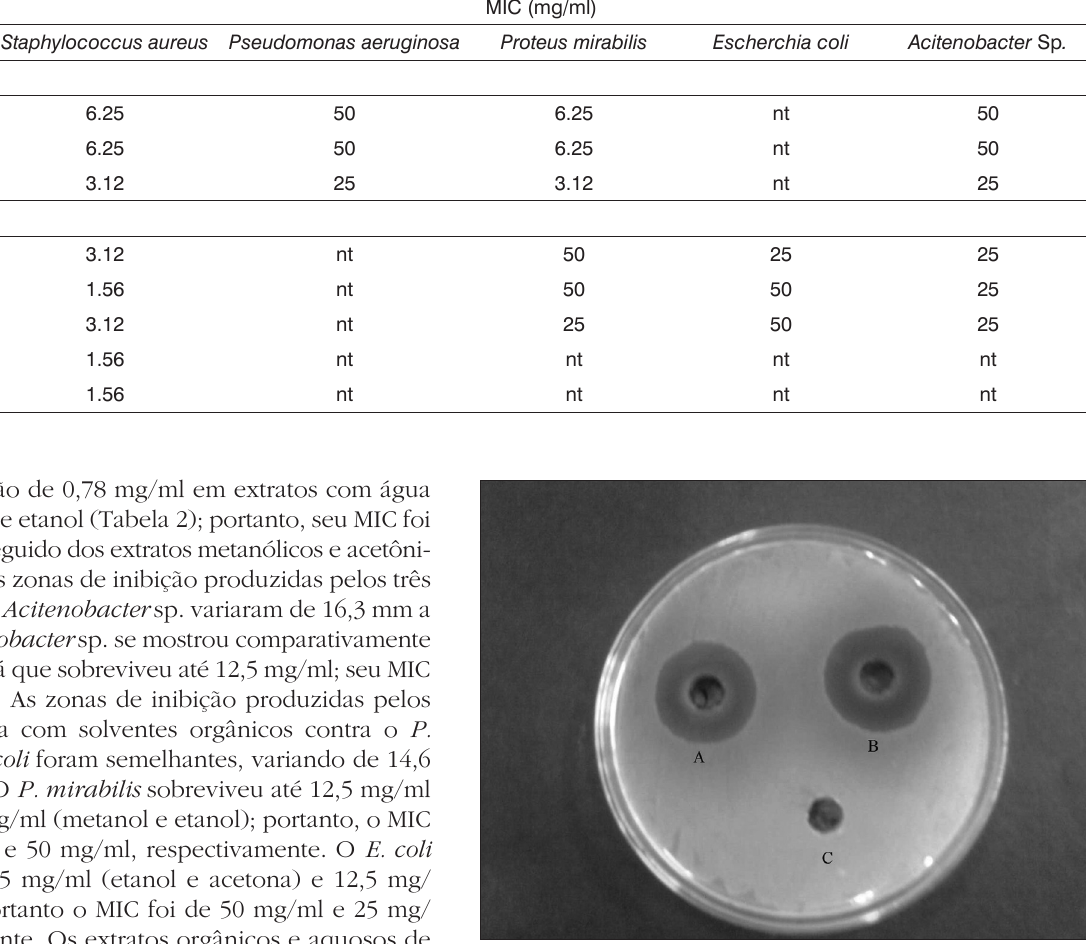
Figura 2. Zona de inibição antibacteriana de extratos aquosos da casca da T. arjuna contra S. aureus por extratos aquosos quente